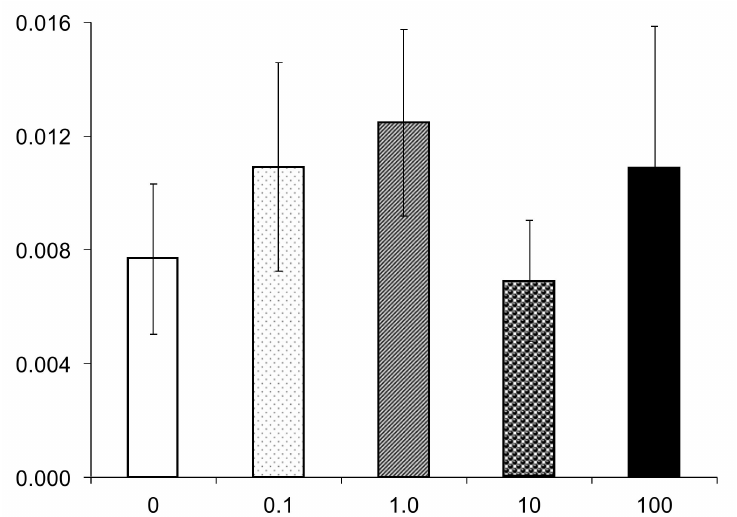
Figure 5. Data characterizing the permeability of the intestinal barrier for macromolecules of protein (OVA) in rats of groups 1–5. X-axis—dose of SiO 2 NPs, mg / kg bw. Y-axis—absorption of OVA macromolecules into the blood, percentage of the administered dose × 10 3 , M ± s.e.m. Data distribution in group is homogeneous (ANOVA F = 0.504; p > 0.1). Paired di ff erences between groups are insignificant, p > 0.1, Mann–Whitney